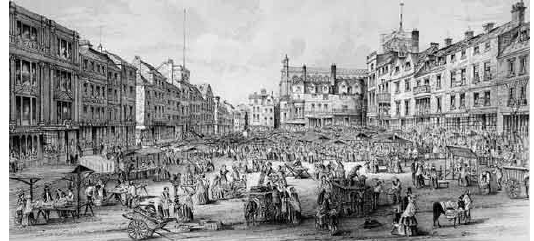
Figure 2. Market place, Norwich. 1854. From: Norwich Museum & Art Gallery.